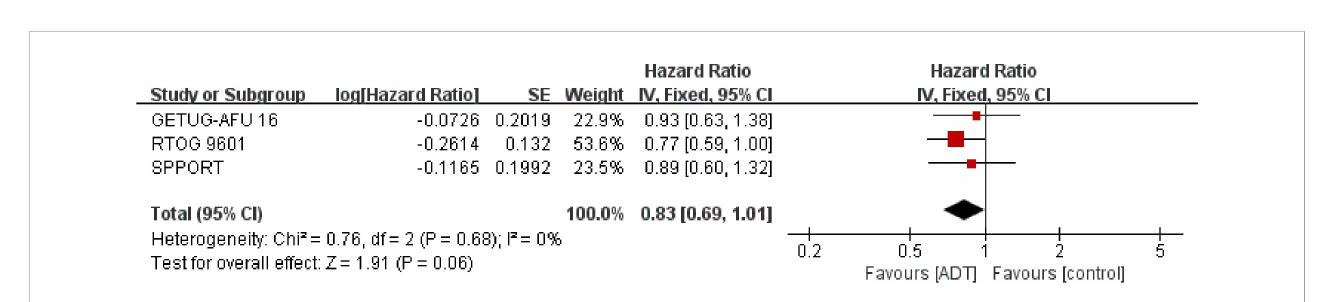
FIGURE 4 Assessment of Overall Survival. The diamond indicates best estimate of the true (pooled) outcome (with width indicating 95% CI). HR, hazard ratio; experimental stands for salvage radiotherapy combined with endocrine therapy; control stands for salvage radiotherapy alone. Since there is no heterogeneity, a fi xed-effects model is